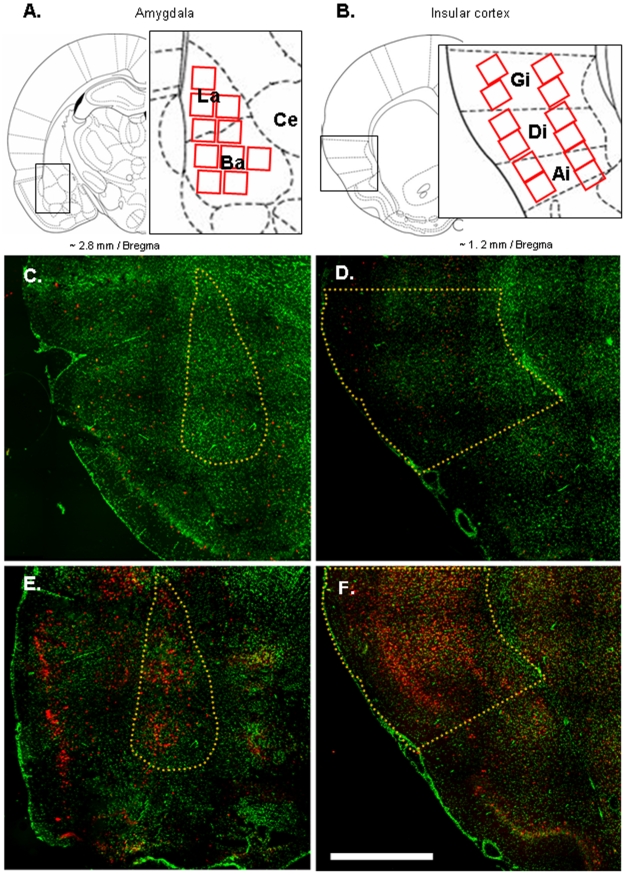
Examples of Arc induction in basolateral amygdala and insular cortex.(A, B) Schematic drawing of brain sections assayed at the level of (A) the basolateral amygdala, and (B) the insular cortex (adapted from Paxinos & Watson, 1998). Each red square represents the regions where image stacks were obtained. Ai: agranular zone of insular cortex; Ba: basal nucleus of amygdala; Ce: central nucleus of amygdala; Di: dysgranular zone of insular cortex; Gi: granular zone of insular cortex; La: lateral nucleus of amygdala. (C, D, E, F) Representative fluorescent images at the level of the basolateral amygdala (C, E) and insular cortex (D, F) using the Apotome microscope system (Zeiss). Green is the Sytox green nuclear staining and red is the Cy3 signal used to detect Arc mRNA. Images taken from the Caged control rats (C, D) and from the Paired animals exposed to odor and taste (E, F). The yellow lines delineate the basolateral amygdala and insular cortex. Scale bar, 1mm.